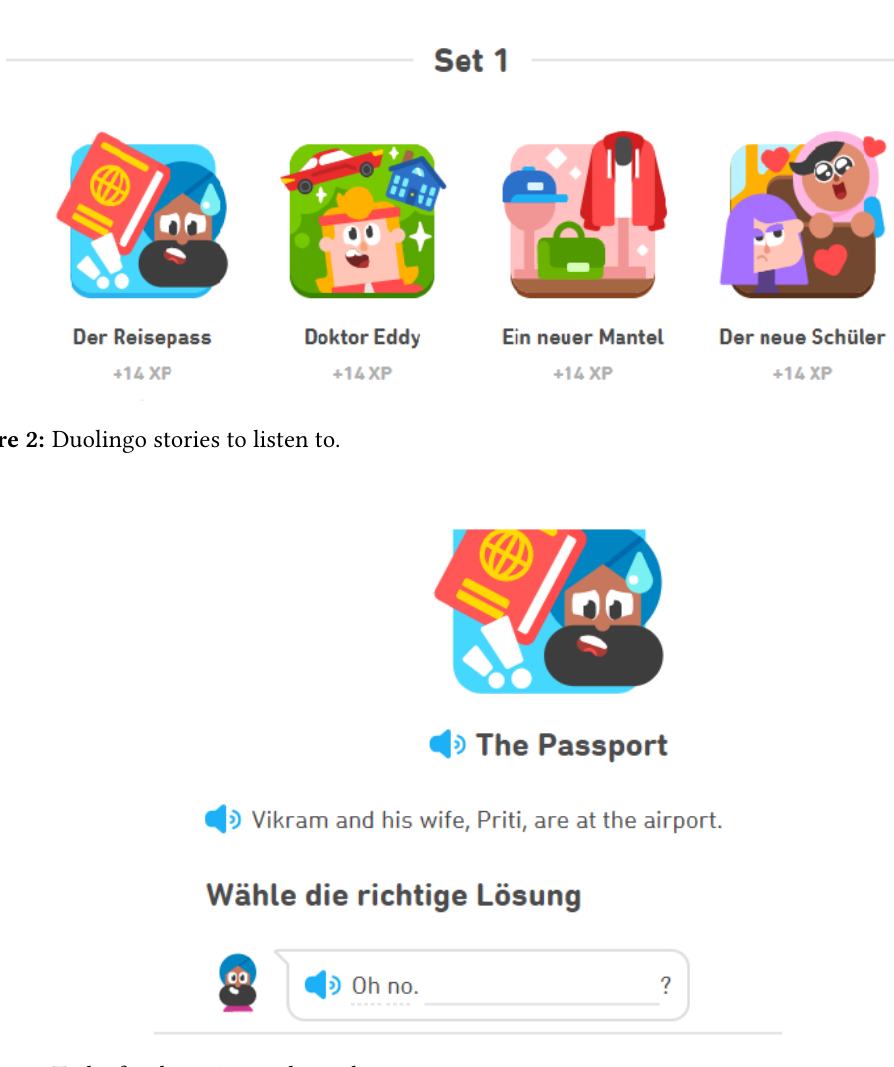
Figure 3: Task after listening to the